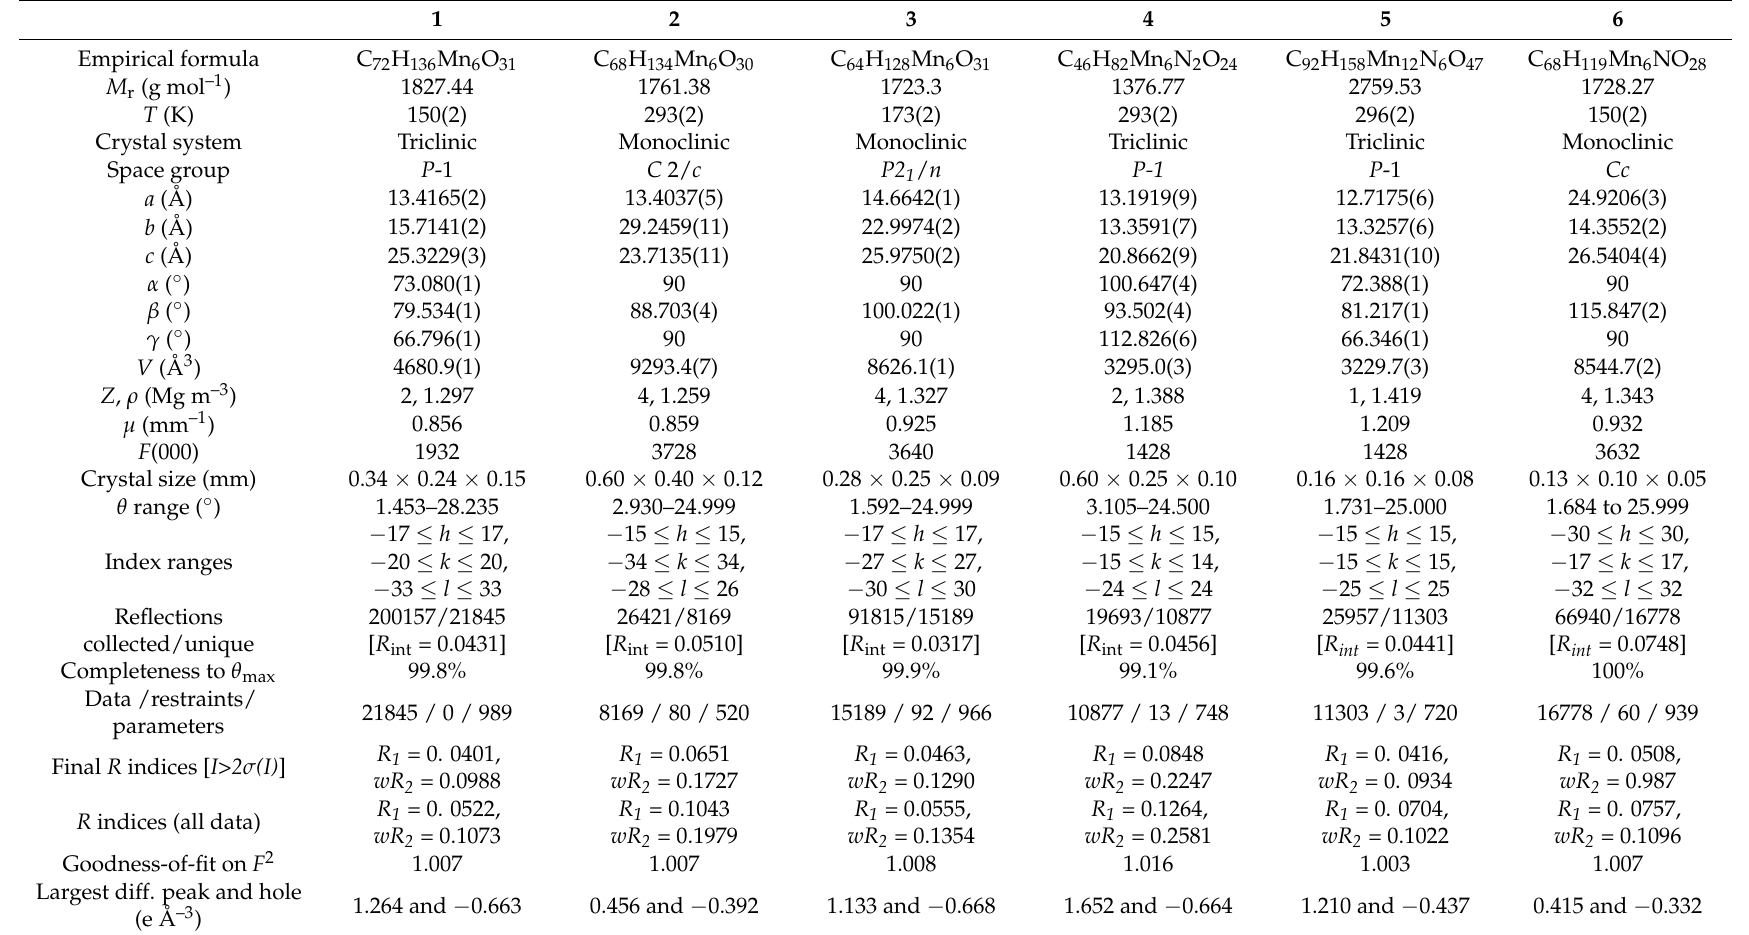
Table 1. Crystal data and details on the structure refinement for 1 –